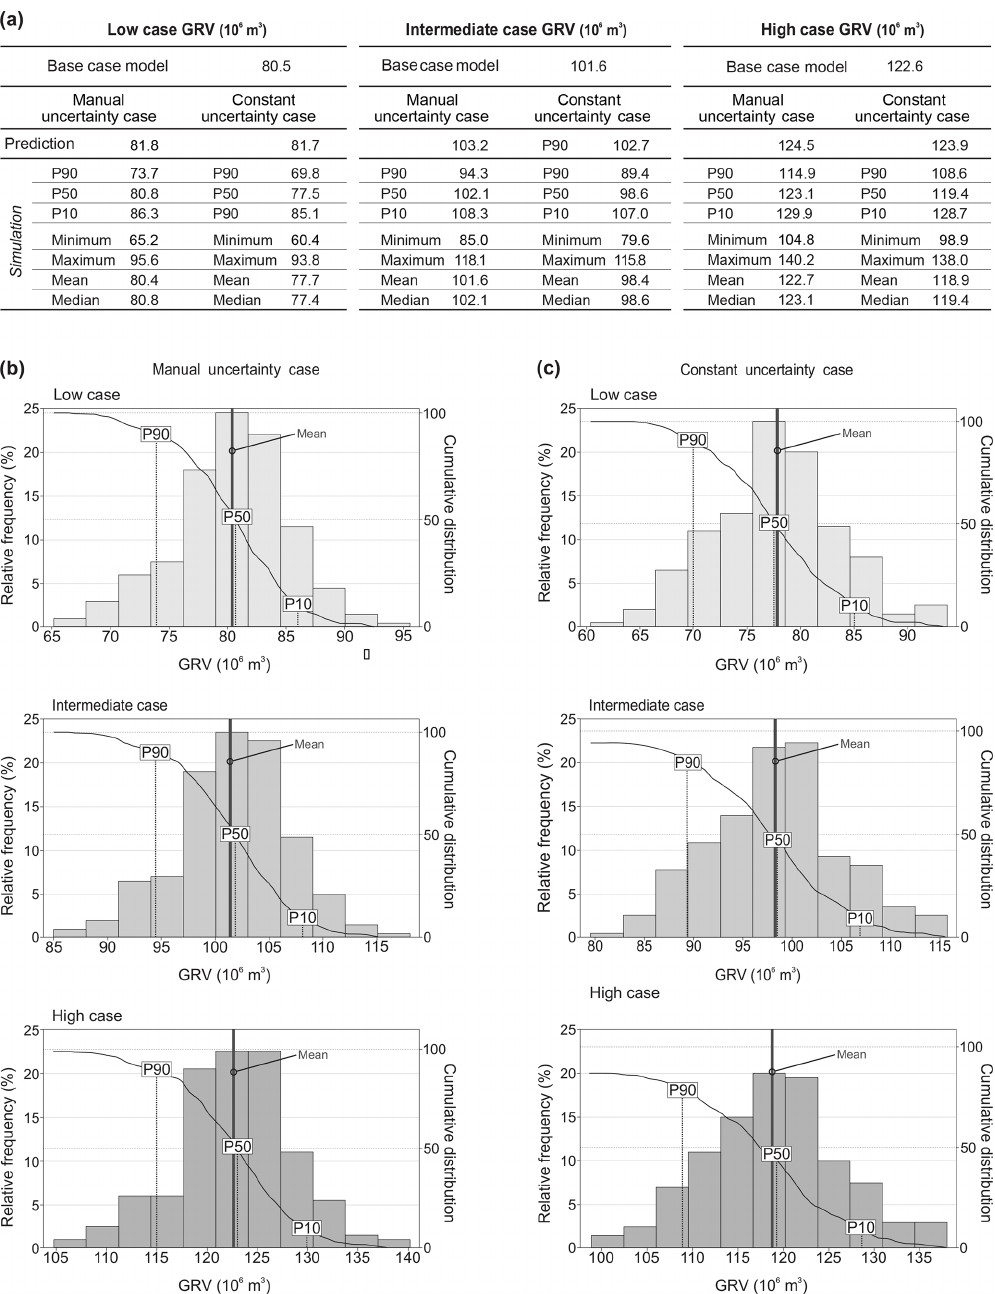
Figure 10. Gross rock volumes (GRVs) calculated from the models obtained with the manual and the constant uncertainty workflows. (a) GRV of the base case model, of the predicted models and of realizations corresponding to the proved (P90), probable (P50) and possible (P10) for the manual and the constant uncertainty cases in the low, intermediate and high oil–water contact depth cases. The minimum, maximum, mean and median for all simulation cases are also reported. Histograms showing the GRV distribution obtained from the 200 realizations (simulation method) of (b) the manual uncertainty case and of (c) the constant uncertainty case for the three oil–water contact depth cases. The mean GRVs in all cases are also